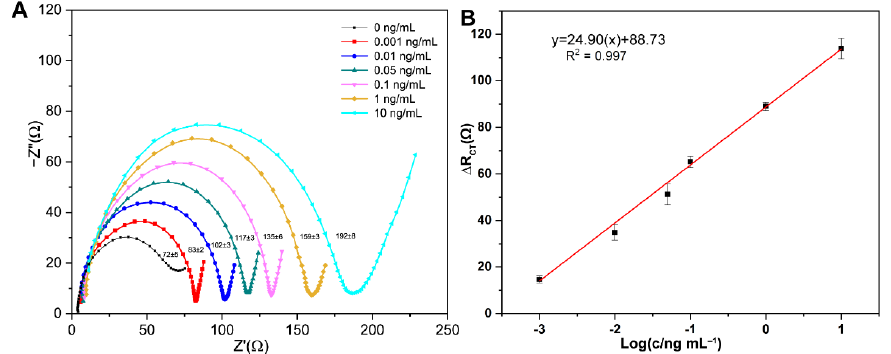
Figure 6. ( A ) Nyquist plots of aptasensor with different concentrations of OTA (0–10 ng/mL) and ( B ) The calibration curve of aptamer corresponding to the detection of OTA based on the change in electron-transfer resistance (R CT ), which is presented as Δ R CT . Table 1. Comparison of the developed impedimetric aptasensors for OTA detection.